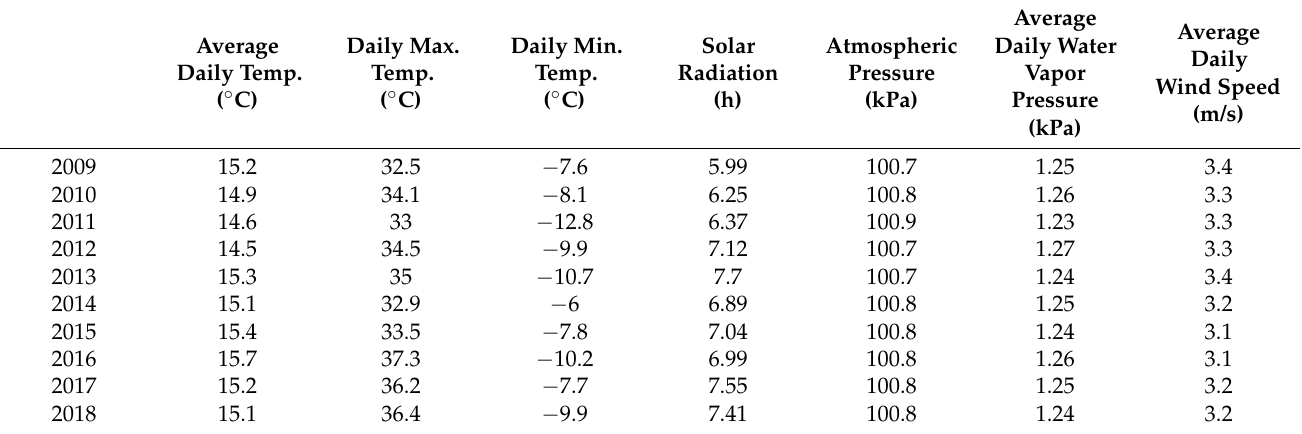
Table 3. Factors for the estimation of ET 0 .